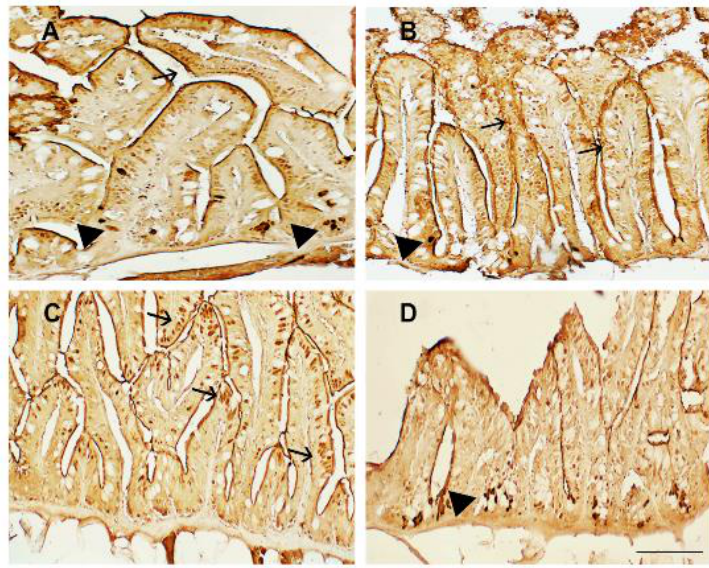
Figure 2. TNFα immunostaining in the intestine s of ( A ) zebrafish fed a plant-based diet (control); ( B ) TSP I, zebrafish fed a plant-based diet supplemented with TSP at 0.9 g/kg of feed; ( C ) TSP II, zebrafish fed a plant-based diet supplemented with TSP at 1.7 g/kg of feed; and ( D ) TSP III, zebrafish fed a plant-based diet supplemented with TSP at 3.4 g/kg of feed. Scale bar: 100 µ m. Arrows indicate epithelial cells, and black arrowheads indicate infiltrated leukocytes expressing TNFα.